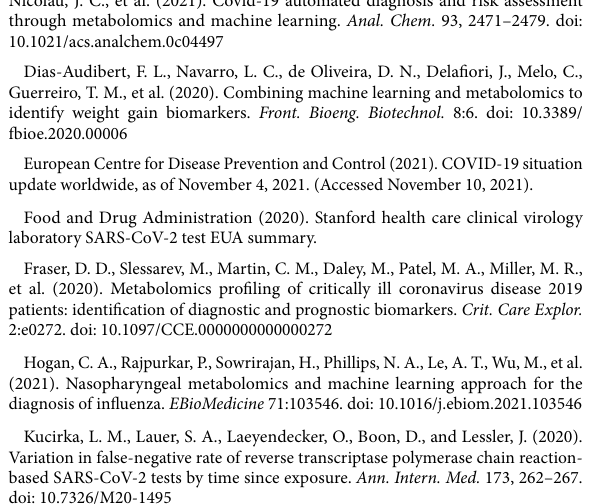
SUPPLEMENTARY TABLE 1 Multivariable linear regression model for SARS-CoV-2 status prediction adjusted for age, sex, and machine learning output. Model output was observed to be the most significant feature associated with infection status prediction. SUPPLEMENTARY TABLE 2 Median concentrations of the top 20 amino acids in COVID-19 positive and negative samples. SUPPLEMENTARY FIGURE 1 Flowchart of the specimen selection for assessment of the plasma targeted amino acid method. SARS-CoV-2: severe acute respiratory syndrome type. SUPPLEMENTARY FIGURE 2 Amino acid concentration by LC/MS–MS standard curve analysis in SARS- CoV-2-positive vs. negative specimens for the top 20 differentiating amino acids. SUPPLEMENTARY FIGURE 3 Amino acid concentration by LC/MS–MS standard curve analysis in SARS- CoV-2-positive vs. negative specimens for the top 20 differentiating amino acids, stratified by C-reactive protein status. The x-axis categories are listed in the following left to right order: Negative/high CRP, Negative/ normal CRP, COVID/high CRP, COVID/normal CRP. CRP: C-reactive